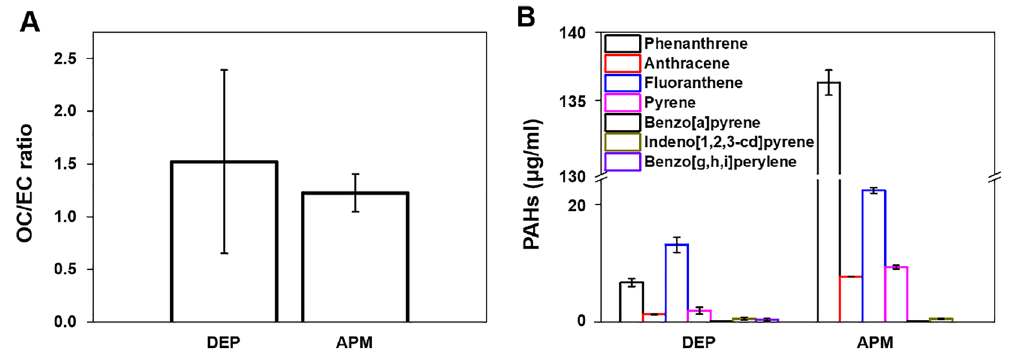
Figure 1. Compositions in DEP and APM. ( A ) OC/EC ratio and ( B ) concentration of PAHs in DEP and APM. Data represent mean ± SD (n = 3). OC organic carbon, EC elemental carbon, PAH polycyclic aromatic hydrocarbons, DEP diesel exhaust particulate, APM artificial particulate